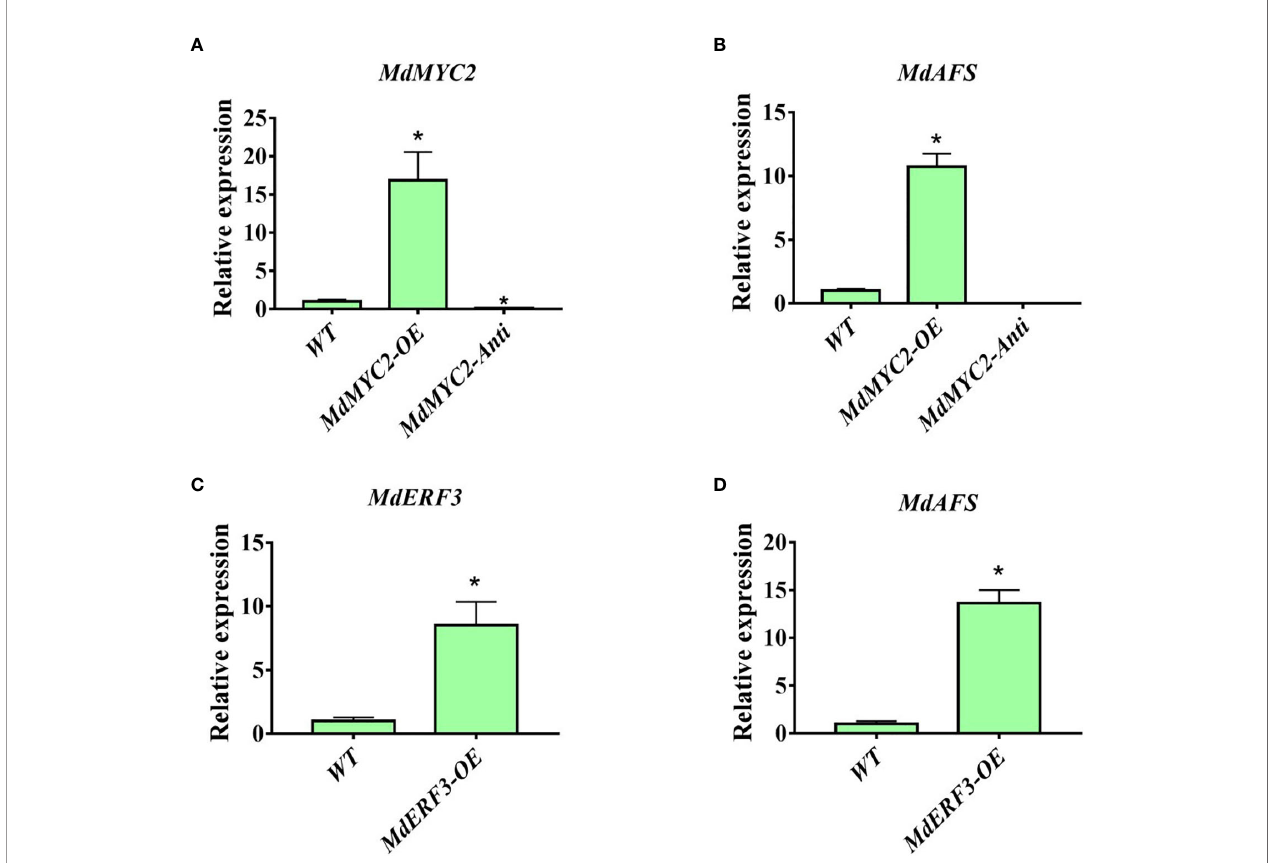
FIGURE 4 | Expression analysis of MdAFS , MdMYC2 , and MdERF3 in transgenic apple calli. (A) Expression level of MdMYC2 in apple calli overexpressing and silencing MdMYC2. (B) Expression level of MdAFS in apple calli overexpressing and silencing MdMYC2. (C) Expression level of MdERF3 in apple calli overexpressing